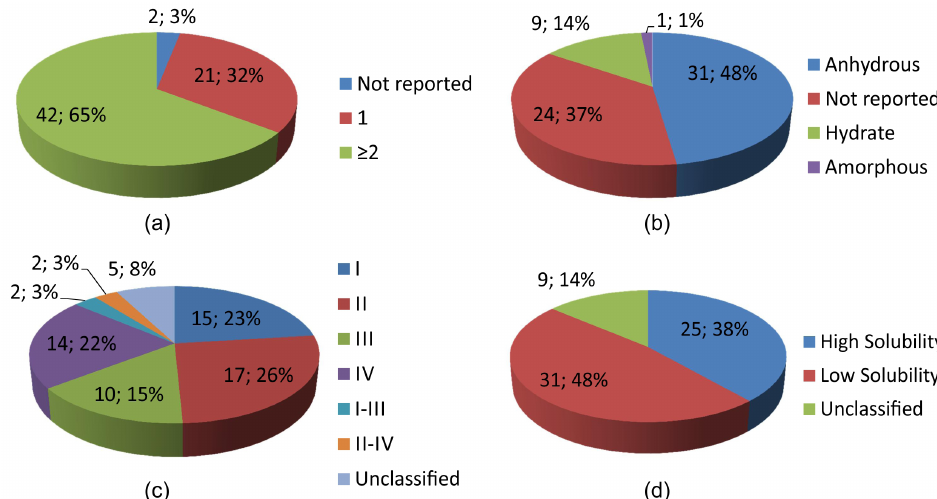
FIGURE 1. Statistical features of the 65 APIs available as solid formulations at the FPRP. (a) The number of different crystal structures (polymorphs when there are more than one structure); (b) the types of solid forms expected to be present in the solid formulation; (c) the distribution in the BCS (I = high permeability, high solubility; II = high permeability, low solubility; III = low permeability, high solubility; and IV = low permeability, low solubility); and (d) the distribution in the BCS indicating the APIs with high solubility (classes I and III) and low solubility (classes II and